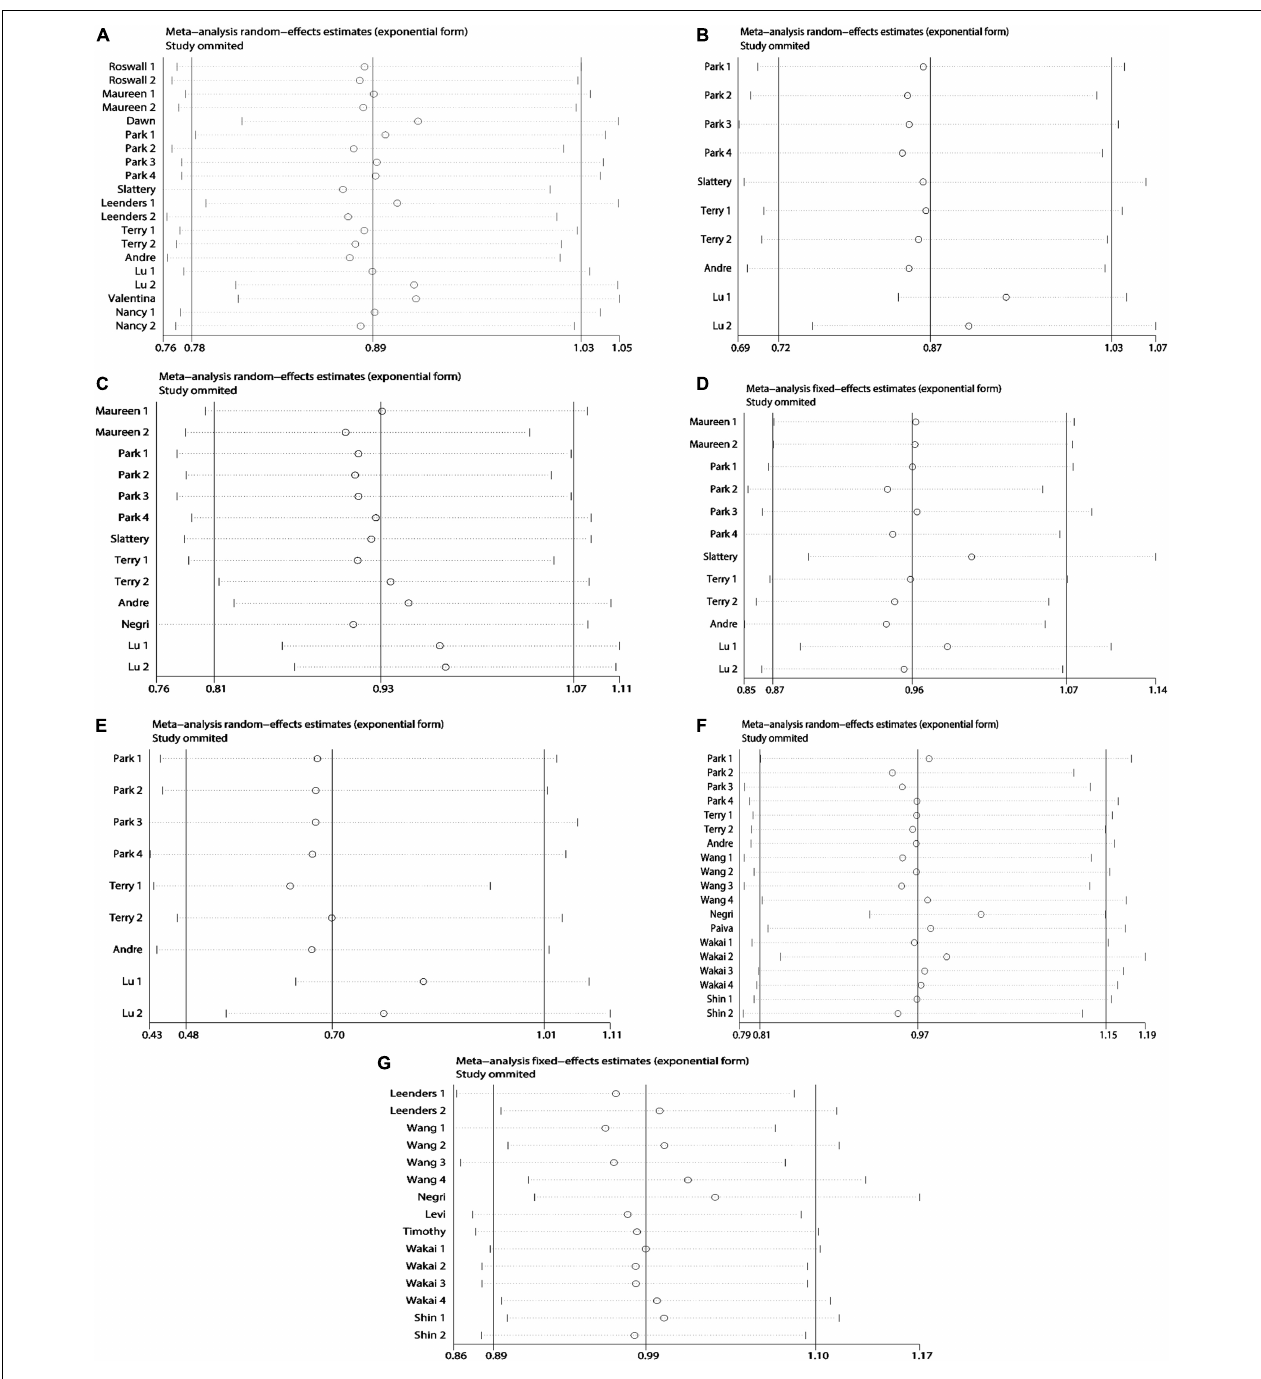
FIGURE 8 | Sensitivity analysis plots on dietary carotenoids and retinol and colorectal cancer risk. (A) β -carotene; (B) α -carotene; (C) lycopene; (D) lutein/zeaxanthin; (E) β -cryptoxanthin; (F) carotenoids; (G)